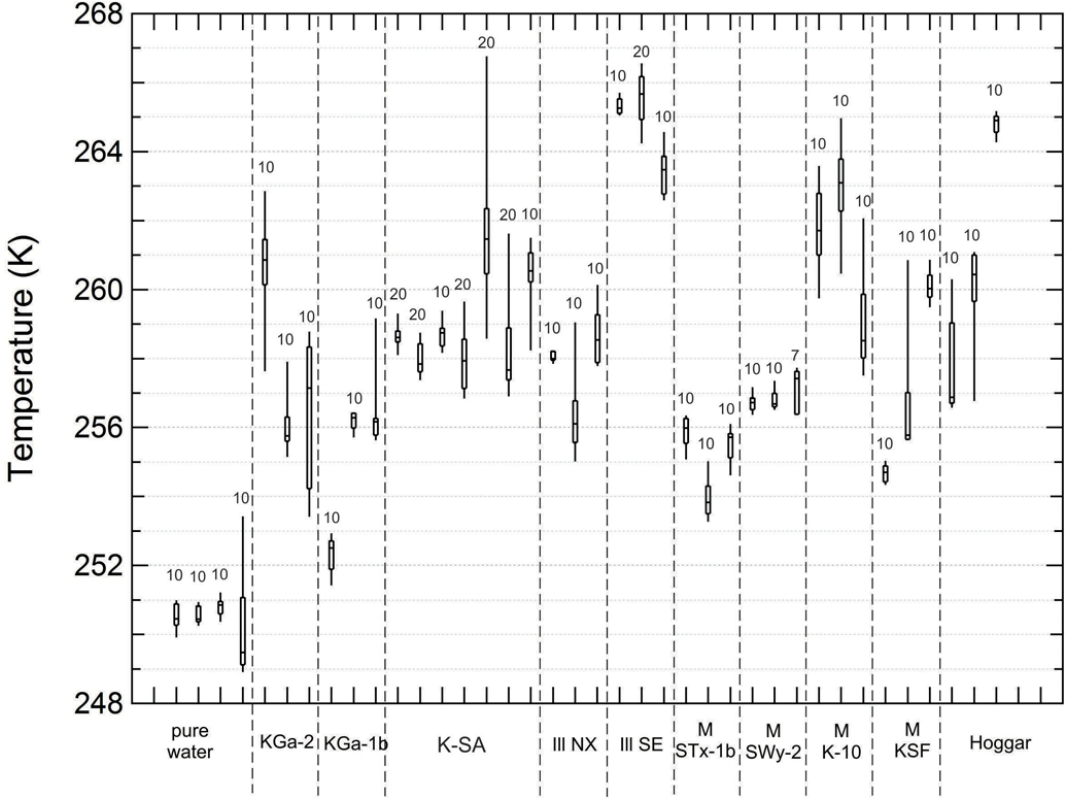
Fig. 8. Box and whisker plot of bulk measurements of the investigated samples with 5wt% of suspended clay mineral (except pure water on the left). The upper and lower boarders of the box are given by the upper and lower quartile, respectively, and the horizontal line in the ) . The highest and lowest values in a particular experiment are shown by the ends of middle of the box shows the value of the median ( T best med the whiskers. Different clay minerals are separated by dashed vertical lines. The numbers on each box represent the number of